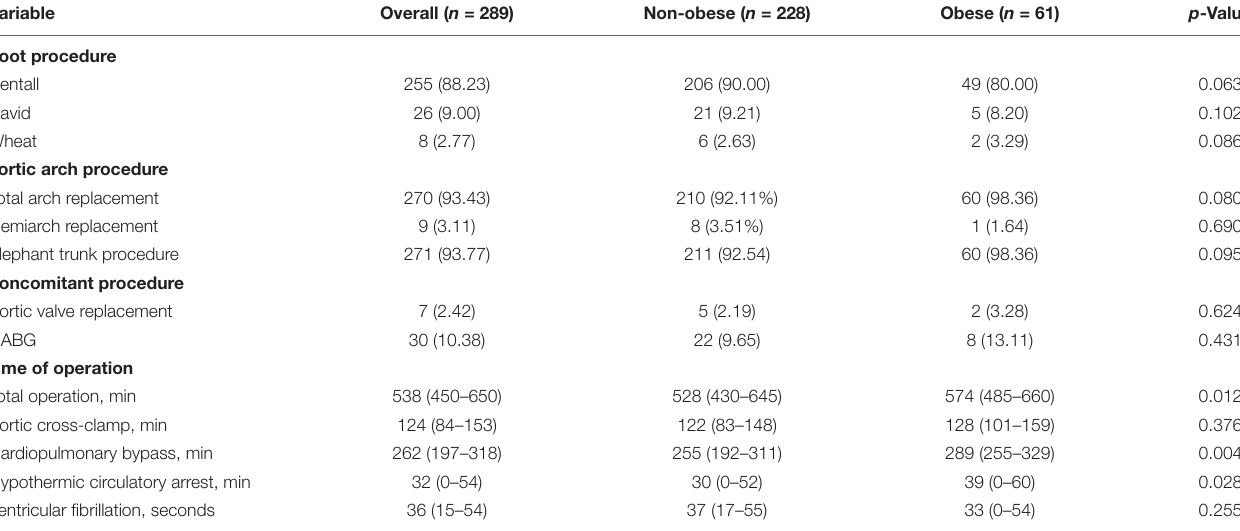
TABLE 3 | Intraoperative details.